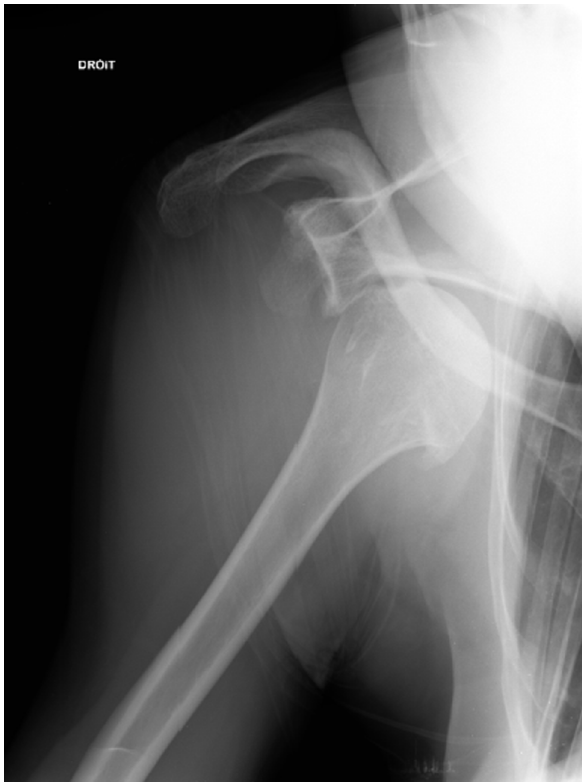
Figure 1. Anterior shoulder luxation.